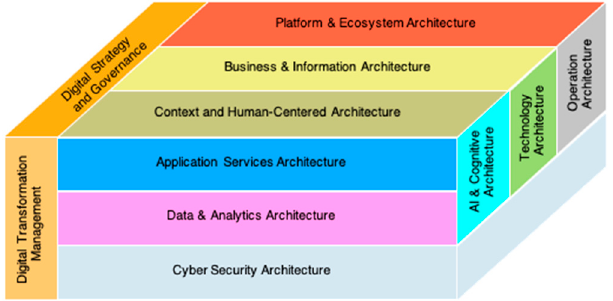
Figure 2. Digital enterprise architecture reference cube.